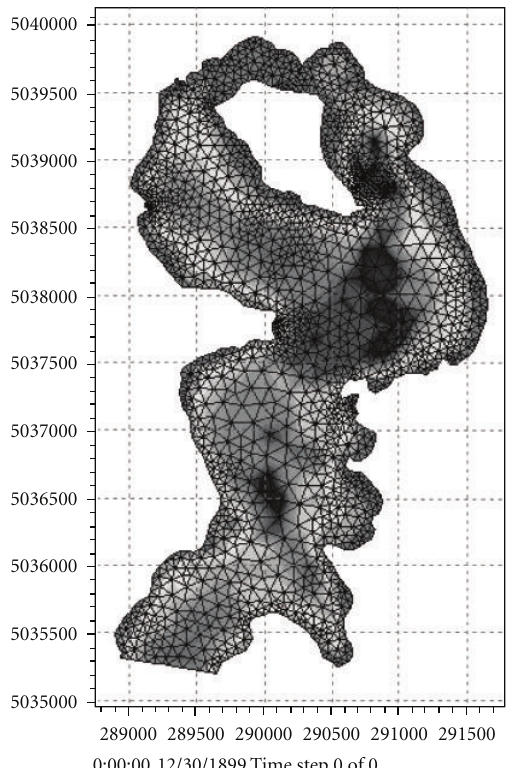
Figure 7: The finer mesh used to evaluate dependence of the modeling accuracy on mesh